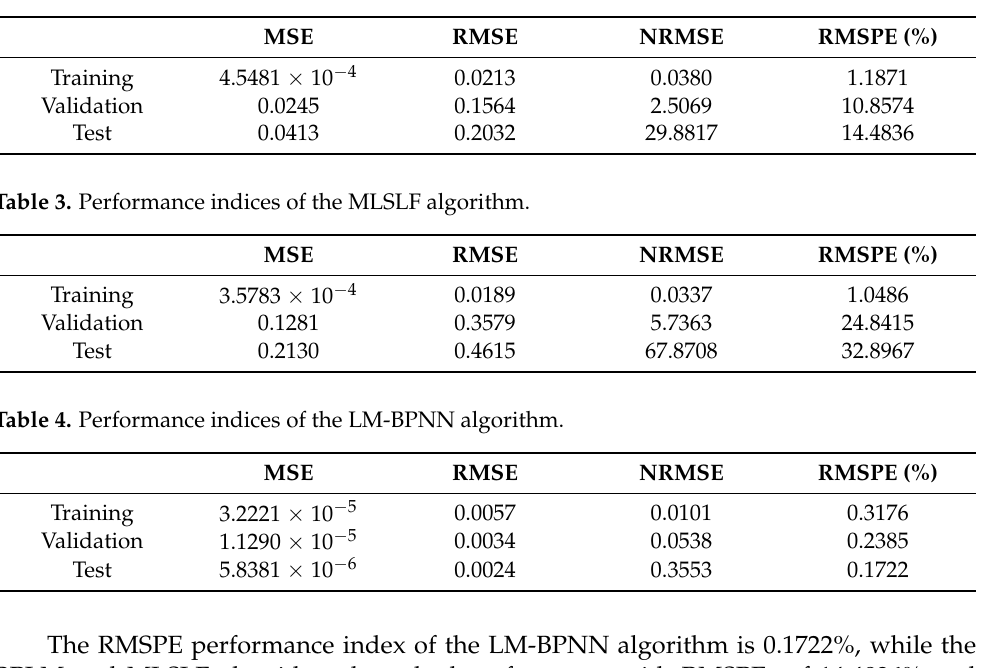
Table 2. Performance indices of the BPLM algorithm.